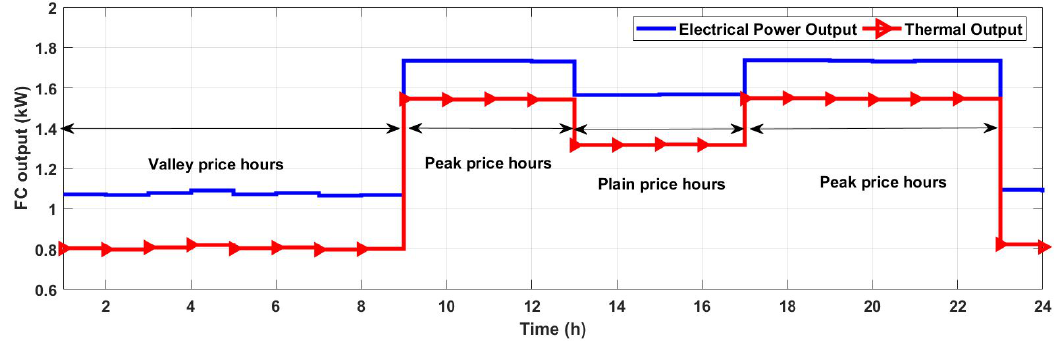
Figure 9. Case 4: Impact of peak-valley tariff on fuel cell